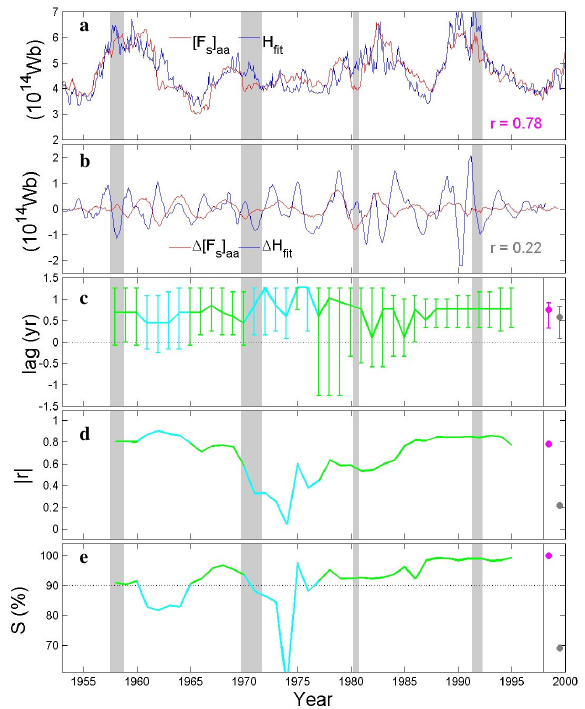
Figure 7. Results of the correlation analysis of Huancayo/Hawaii neutron monitor (>13GV) counts H and the open solar flux deduced from the geomagnetic aa index [Fs] aa . The grey bands mark the times of the reversal in the solar polar field by showing the times between the polar field reversals in the two solar hemispheres. From top to bottom, the panels show: (a). the variations of [Fs] aa (red) and H FIT , the best linear regression fit of H to [Fs] aa (blue); (b). the band-pass filtered variations D [Fs] aa (red) and D H FIT , the best linear regression fit of D H to D [Fs] aa (blue); (c) the lag of the peak correlation, d t; (d) the magnitude of the peak correlation coefficient |r|, and (e) the significance of that correlation, S. The mauve and the grey data points to the right of (c), (d) and (e) give the values for the full, raw data sequences shown in the top panel (in mauve) and the filtered data sequences (in grey). The correlation of D [Fs] aa and D H is low (r = 0.22) because of the smoothing inherent [Fs] aa , so only data points for [Fs] aa and H are shown in (c), (d) and (e), computed for each 6-year interval as shown in figure 5: data points in green have S ‡ 90% (the dotted line shown in the bottom panel), those in cyan have S < 90%.